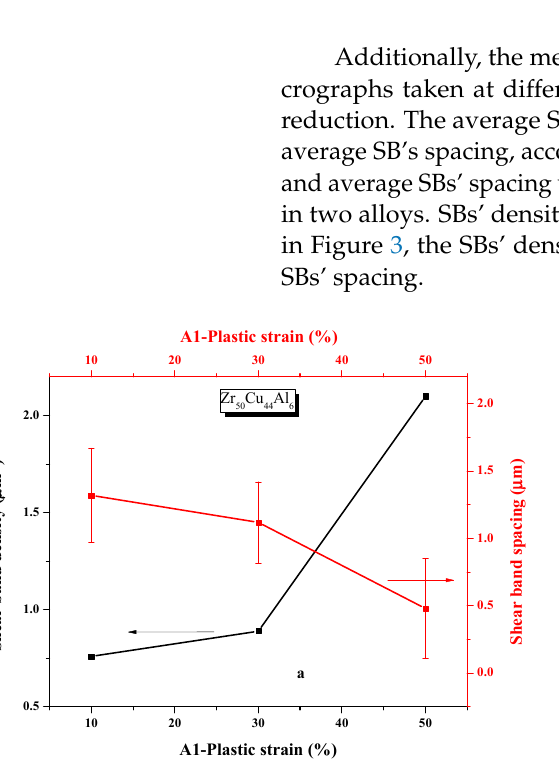
Figure 3. The density and spacing of SBs as a function of the plastic strain of ( a ) A1 and ( b ) A2 RT rolled ribbons. Using black lines to present the trend of SBs’ density and red lines to present the trend of SBs’